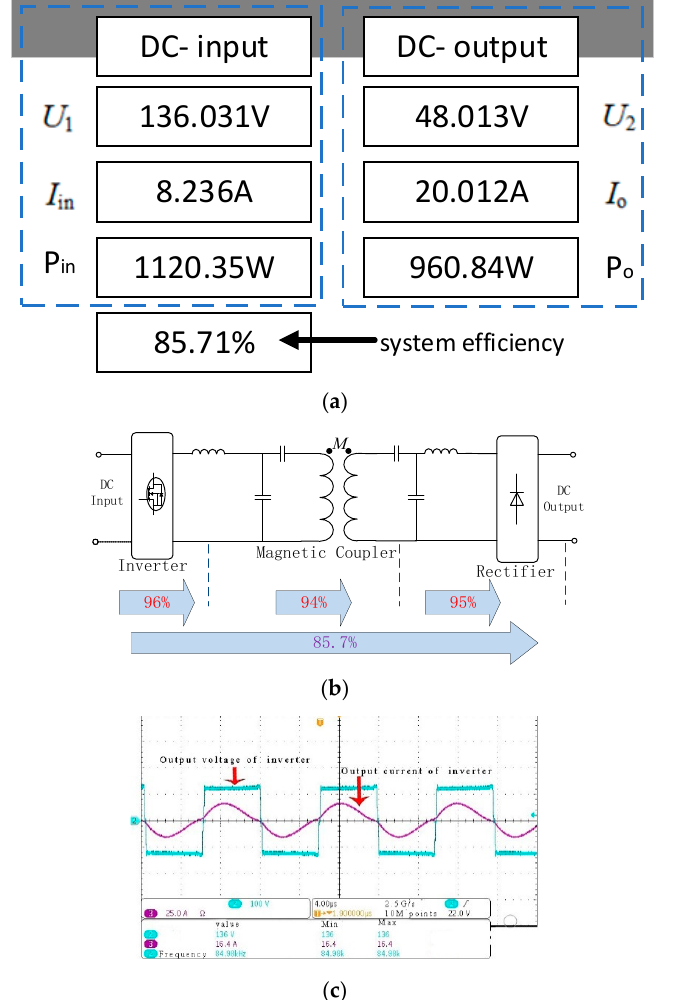
Figure 19. Rated power test for the 2.4 Ω fixed resistive load. ( a ) DC-input and charging output power. ( b ) System Loss Analysis. ( c ) Inverter working waveform.